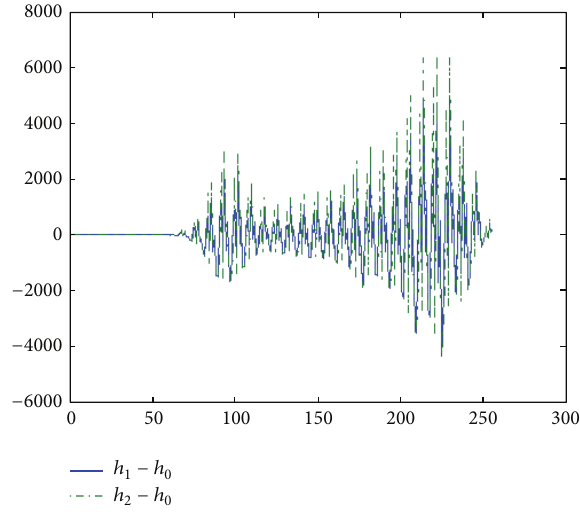
Figure 4: Two kinds of differences